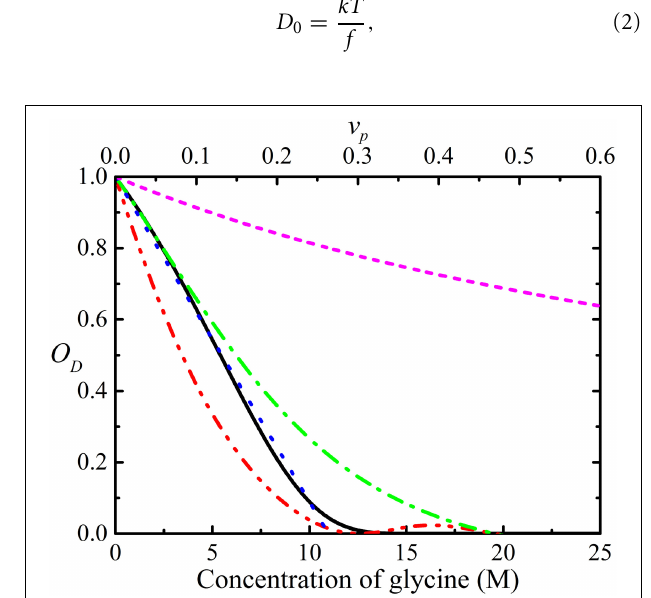
FIGURE 4 | Simulations of the obstruction factor, O D , as a function of the concentration of glycine in water, using the models of Jönsson et al. ( ) [65], Han and Herzfeld ( ) [48], Lekkerkerker and Dhont ( ) [71], T and O short ( ) and long ( ) range hydrodynamic interactions [70, 73]. Note: while glycine is only soluble up to ∼ 5M under standard conditions, the graph depicts obstruction up to much higher concentration. The equivalent volume fractions ( v p ) are shown in the secondary x -axis.